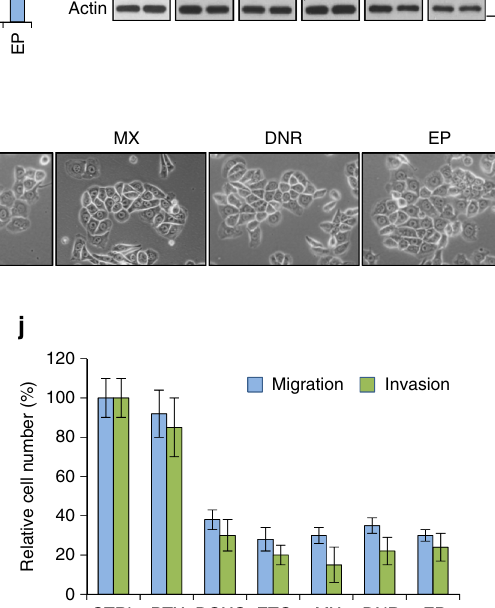
results implied that nuclear β -catenin downregulation may be the mechanism by which etoposide-mediated TOP2B degradation inhibits the EMT/ β -catenin/STT3/PD-L1 axis. As expected, β - catenin knockdown, similar to etoposide, suppressed STT3 and PD-L1 in mesenchymal cancer cells (Fig. 8h, lanes 2 and 3) and rendered cells insensitive to etoposide or sg-TOP2B treatment (Fig. 8h, lanes 4 and 8), supporting the notion that etoposide- mediated TOP2B degradation and subsequent inhibition of the